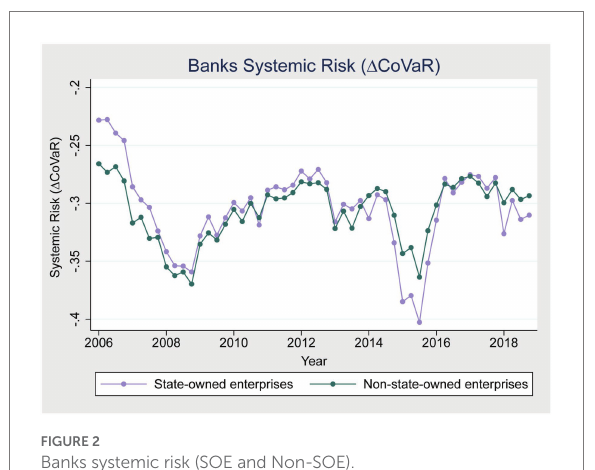
FIGURE 2 Banks systemic risk (SOE and